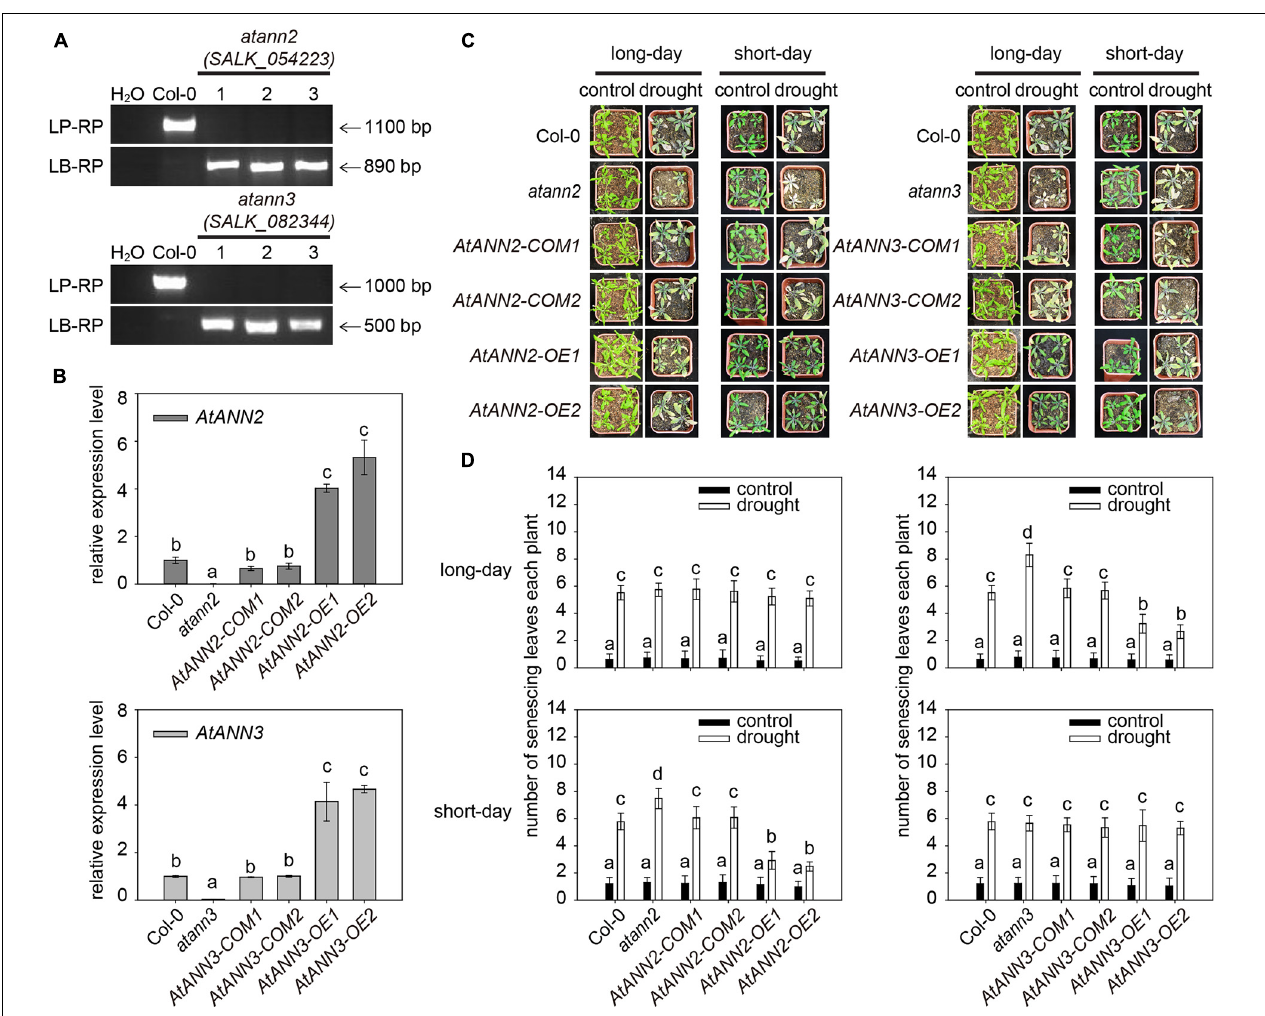
FIGURE 1 | Functional regulation of AtANN2 and AtANN3 in drought tolerance by photoperiod. (A) Isolation and identification of AtANN2 and AtANN3 T-DNA insertion mutants at the DNA level. (B) Identification of AtANN2 and AtANN3 T-DNA insertion mutants at the RNA level by qRT-PCR. (C) Plant growth phenotype (senescing leaves) of genotypes in response to drought stress under long- or short-day conditions. (D) Statistical analysis of senescing leaves of the genotypes shown in Figure 1C . The mean number of senescing leaves per plant was counted ( n = 50). Different letters indicate significant differences with each treatment at P <0.05